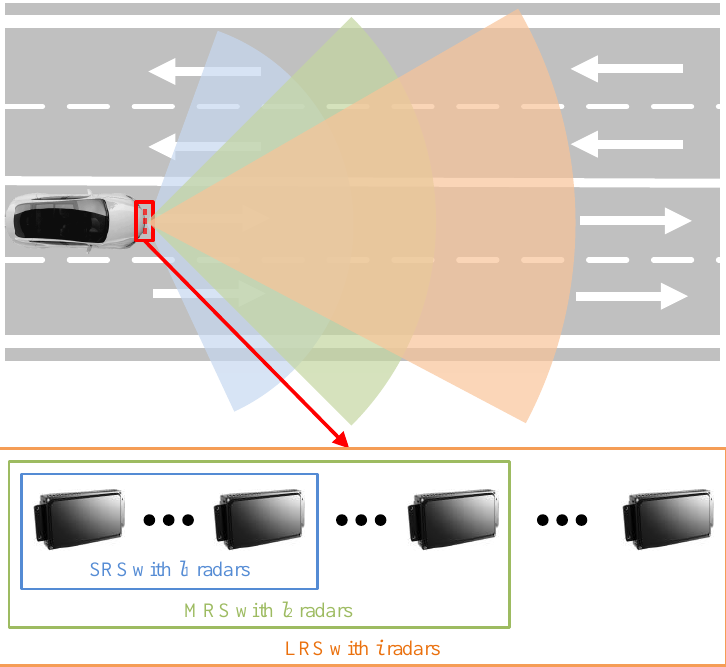
Figure 1. The cooperative automotive radars with multiple heterogeneous radars.